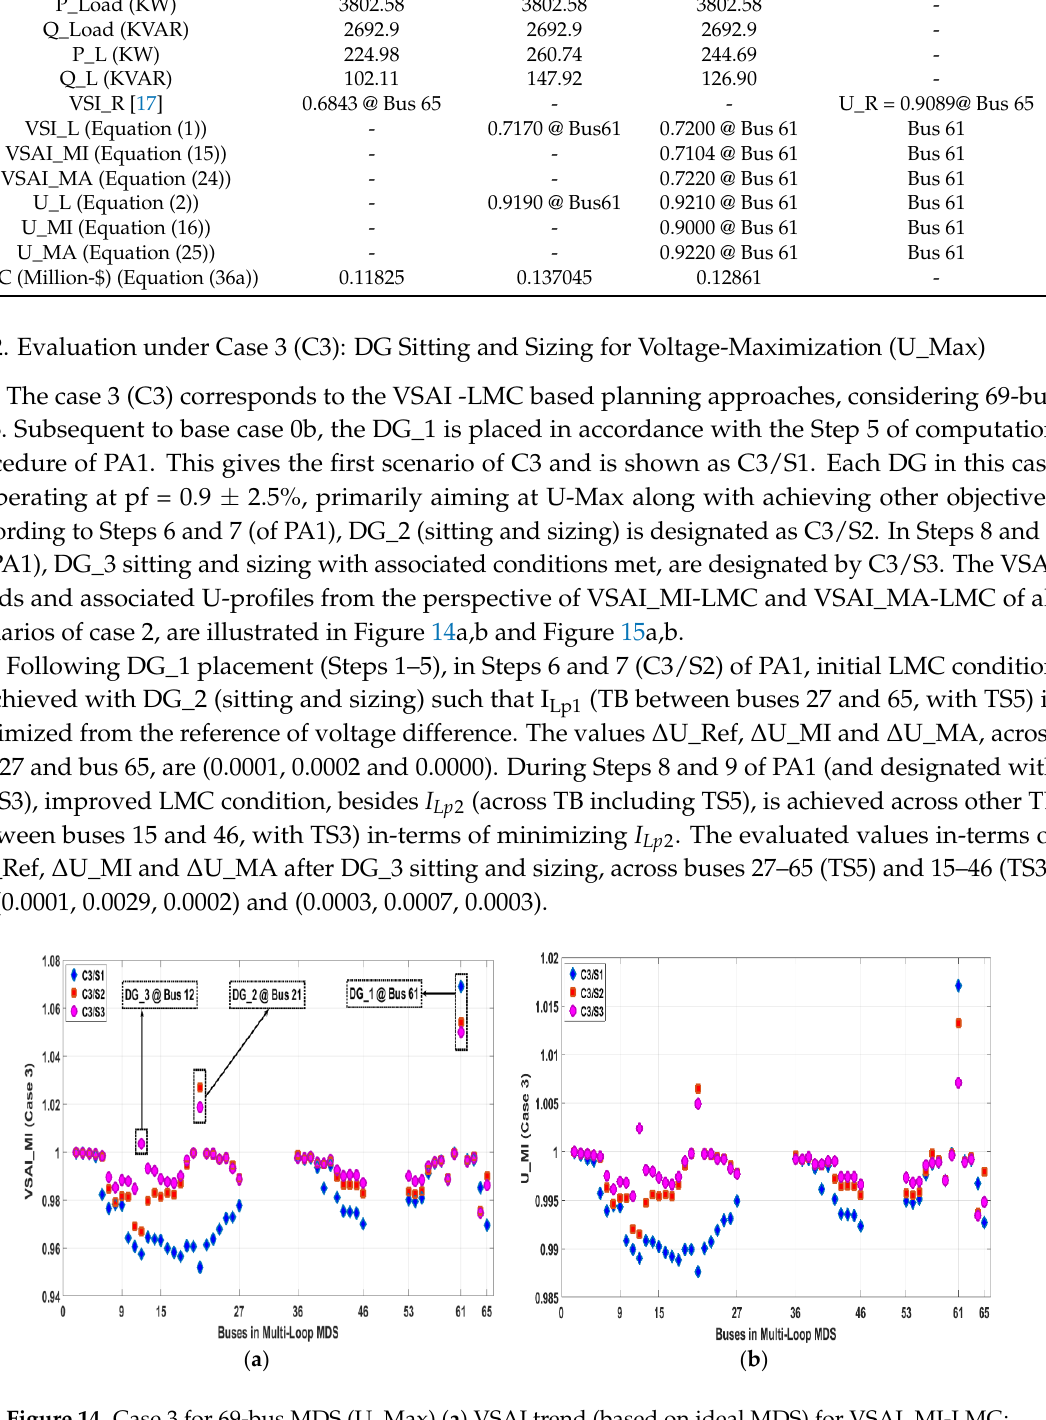
( a ) ( b ) Figure 15. Case 3 for 69-bus MDS(U_Max) ( a ) VSAI trend (based on actual MDS) for VSAI_MA-LMC; ( b ) U-profile trend for VSAI_MA- LMC, based planning approach (DG operating @ pf = 0.9 ± 2.5%). The trend in terms of deviation in voltage based numerical values is observed more in VSAI_MI, in comparison with the VSAI_MA based planning approach. The numerical values achieved in the VSAI trend and U_profile in VSAI_MI-LMC based planning approach shows highest upper metric limits in C3/S1, whereas its more stable in other two scenarios, whereas attained respective results are more stable in VSAI_MA-LMC based approach across all scenarios or C3. Hence, the credibility of the VSAI_MA-LMC based planning approach is validated and supported with respective results. Evaluation of results pertaining to C3 with all associated scenarios is presented in Table 5. The comparative analysis aim at case C3 with all relevant scenarios is illustrated with PEIs in Figure 16a,b. It is observed in Figure 16a that optimal PDG (three DGs) sitting and sizing results in a noteworthy